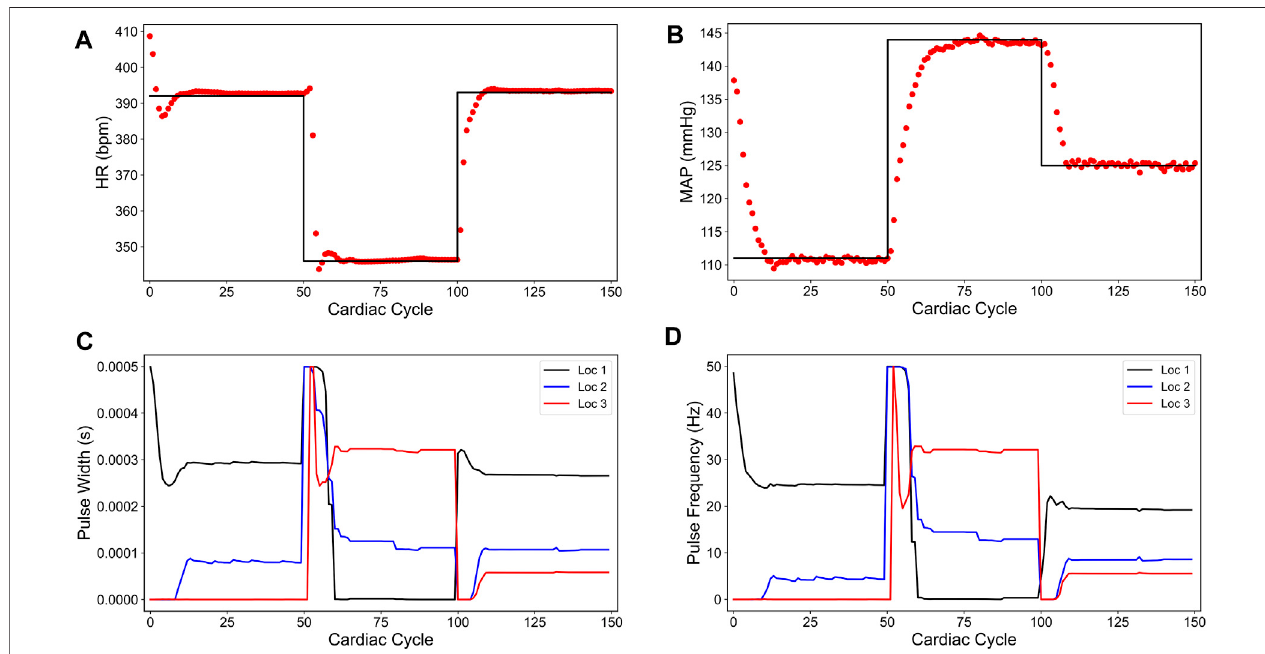
FIGURE 5 | Minimum overshoot-based closed-loop control of the heart rate (HR) and the mean arterial blood pressure (MAP) of the in silico physiological model of the rat cardiac system. (A) and (B) show the closed-loop control response from the in silico physiological model (shown in red dots) and the target (or reference) for the controller (shown in black line) for HR and MAP, respectively. (C) and (D) show the pulse width and the stimulation frequency, respectively, designed by the controller at each VNS location.